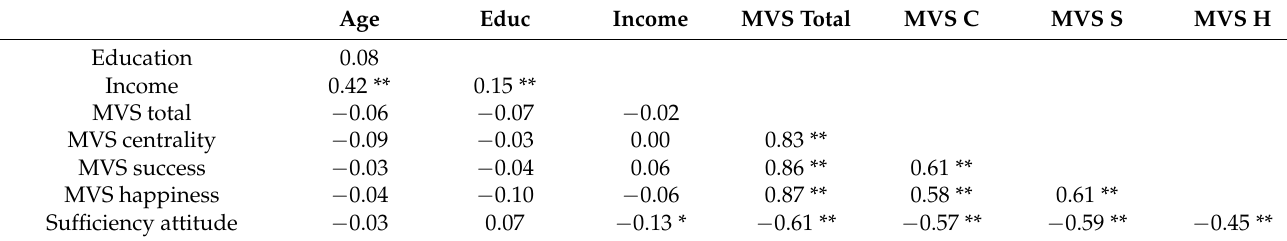
Table 2. Correlations between all variables in Study